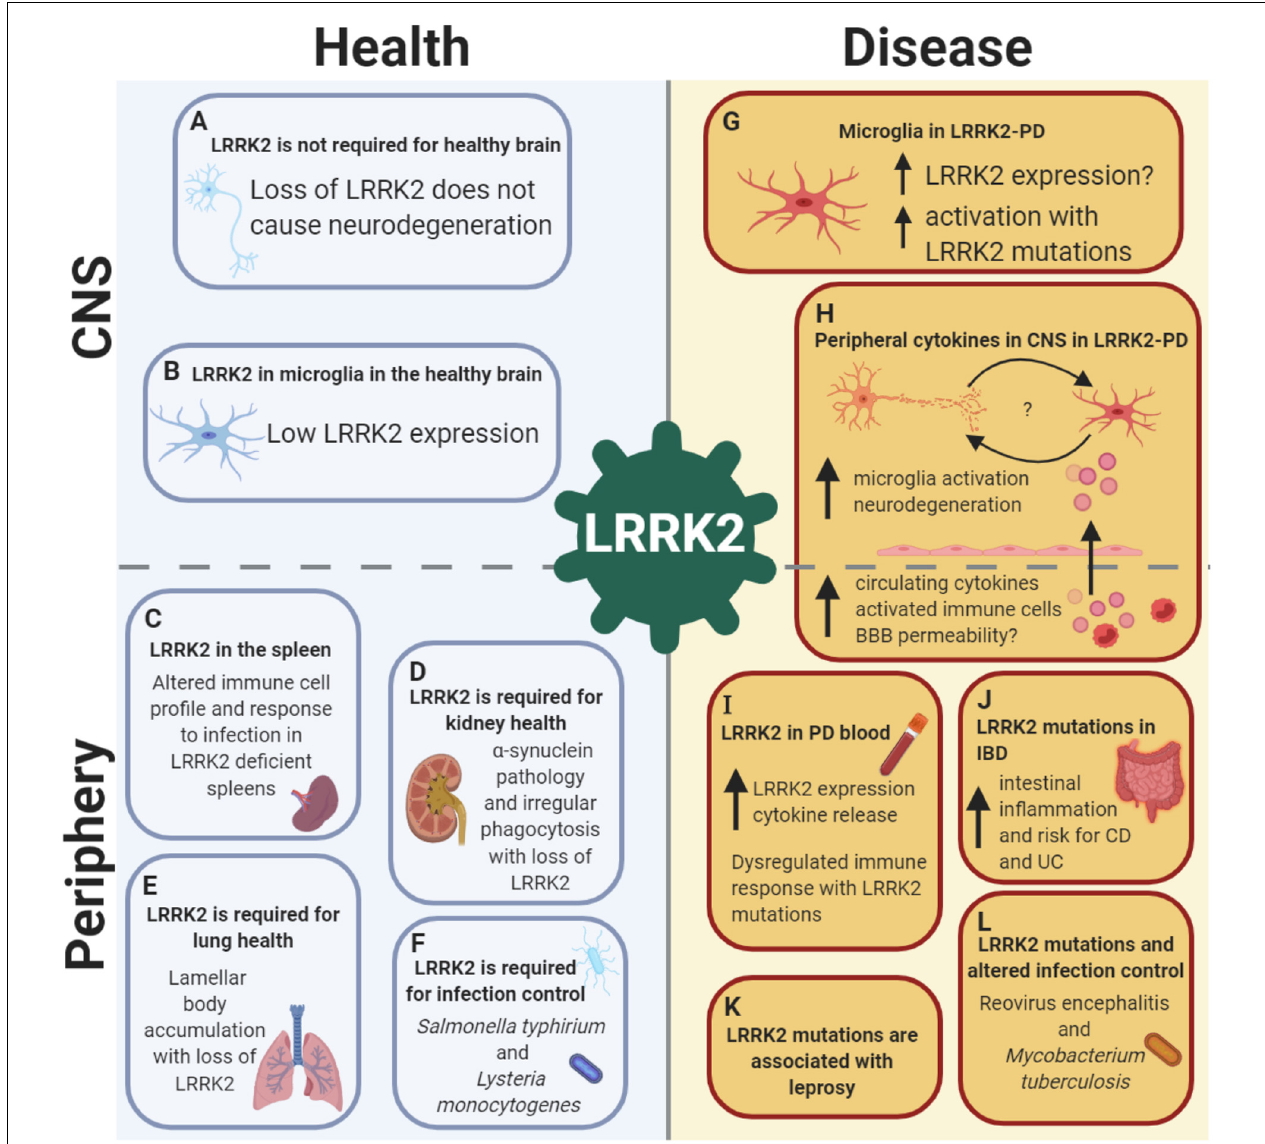
FIGURE 1 | LRRK2 is implicated in health and disease in both the CNS and the periphery, with a crucial role in the immune system. LRRK2 in the healthy brain: (A) LRRK2 may not be essential for neuronal development as global LRRK2 deficiency in rodents is not accompanied by neurodegeneration in dopamine-striatal and other pathways. (B) In the healthy brain, LRRK2 is absent or expressed at low levels in microglia, suggesting a minimal role of LRRK2 in brain-resident innate immune cells under homeostatic conditions. Role of LRRK2 in health in peripheral organs and the immune system: (C) LRRK2 is required for spleen, (D) kidney and (E) lung health, as well as (F) pathogen control and host response to infections such as Salmonella typhirium and Lysteria monocytogenes. LRRK2 in the brain in PD: (G) In LRRK2-PD, LRRK2 expression is increased in microglia, with increased activation of microglia observed with LRRK2 -PD mutations. (H) LRRK2 may exert its effects on the brain from the periphery in PD, with increased circulating cytokines potentially increasing BBB permeability with LRRK2 mutations, causing microglia activation and neurodegeneration, leading to bi-directional interplay between neuronal death and microglia priming. Role of LRRK2 in disease in peripheral organs and the immune system: (I) LRRK2 expression is increased in peripheral immune cells in both LRRK2 and non-LRRK2 PD, with concomitant increases in cytokine release. (J) LRRK2 is associated with gut inflammation, with an increased risk of both Crohn’s disease (CD) and ulcerative colitis (UC) with mutations. (K) LRRK2 risk and protective genetic variants are associated with the infectious and autoimmune disease leprosy. (L) LRRK2 mutations have been shown to alter infection control and host response to Reovirus encephalitis and Mycobacterium tuberculosis. Created with